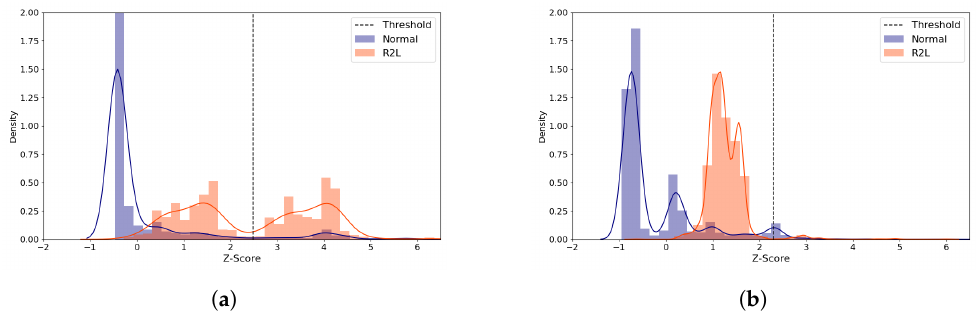
Figure 7. NSL-KDD Reconstruction Distance Density Plot (Normal and R2L attack data) comparing the best and the worst performance cases with the (5,64) model. Blue denotes normal data and orange denotes R2L attack data. A line depicts the kernel density estimated plot, and bar plot depicts the histogram. The dotted line indicates the threshold value, which divides the normal and the attack classes. The X-axis denotes Z -score. The Y-axis is density and limited to 2 for better visibility. ( a ) The best case (Latent size = 3, MCC = 0.712, Threshold = 2.488). ( b ) The worst case (Latent size = 1, MCC = 0.624, Threshold =